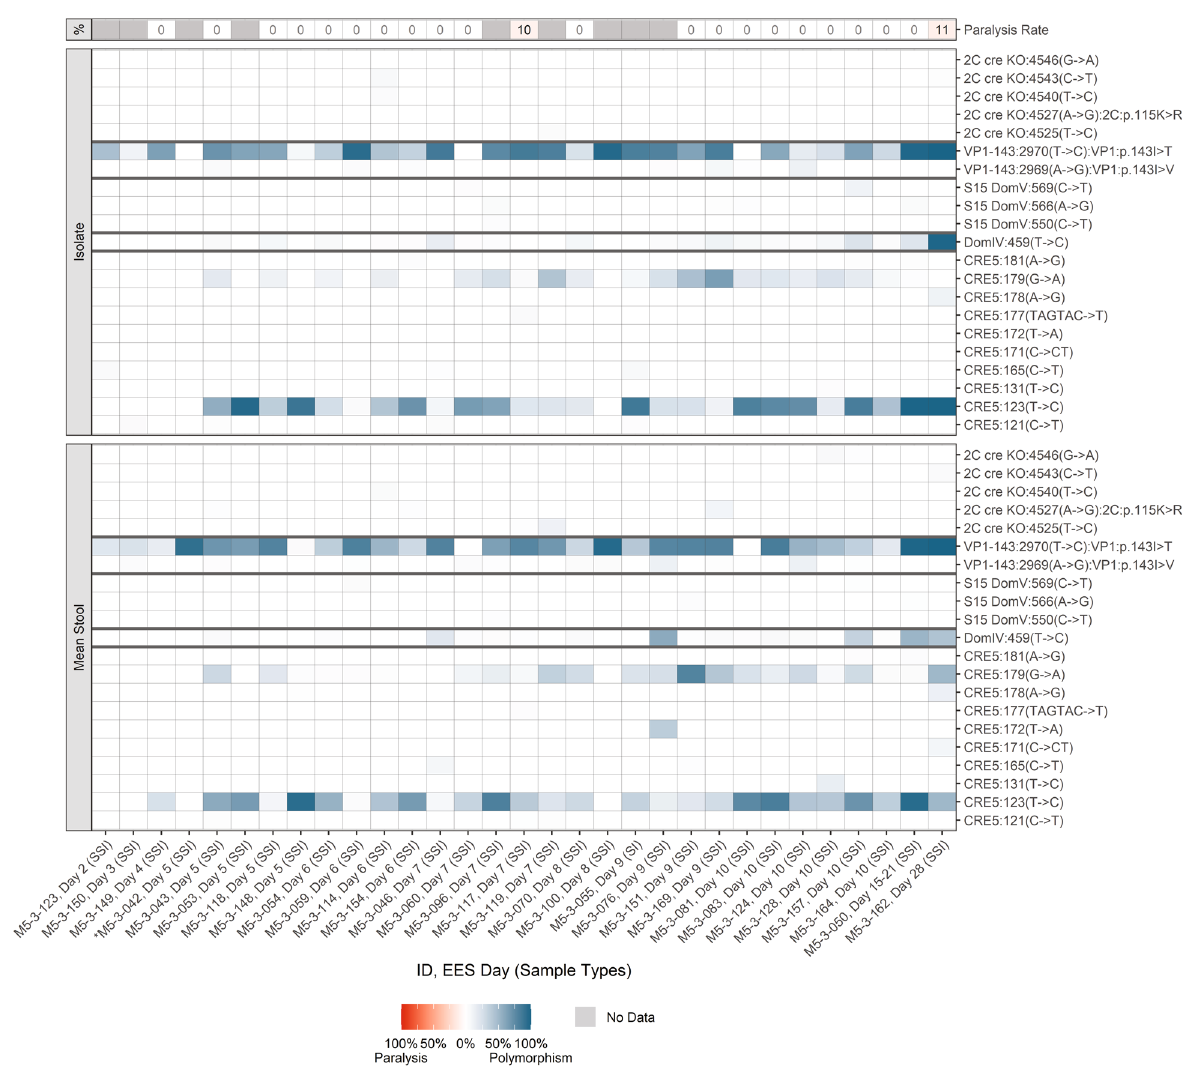
Fig. 3 nOPV2-c1. Frequency of polymorphisms in EES at known attenuation sites and mTgmNVT results. EES day shown with mTgmNVT result (red color gradient) and polymorphism frequency (blue color gradient) averaged across two stool replicates (SS) and culture-ampli fi ed virus (I), if present. Amino acid associated with SNP indicated, if applicable. S = Stool replicate; I = Culture-ampli fi ed virus isolate (SSI = Two stool replicates and culture-ampli fi ed virus isolate; SI = Single stool replicate and isolate). White cells = polymorphism not detected. Gray cells = mTgmNVT result not available or no NGS data from stool (S)/ culture-ampli fi ed virus (I). *Day 5 = Insuf fi cient titer to test EES in mTgmNVT. The NGS pipeline reports SNPs. Coding impact assumes changes are not in common genomes when multiple polymorphisms are observed in VP1- 143. All SNPS reported have Q scores ≥